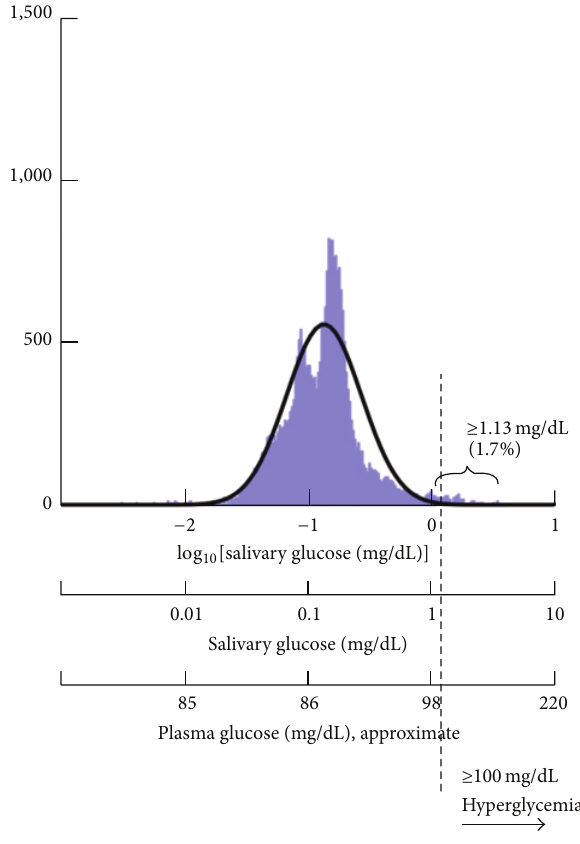
Figure 1: Semilogarithmic distribution of salivary glucose concen- tration values. Approximate values of the concentration of plasma glucose were computed from the equation [plasma = 13.5 × saliva + 84.8] [10]. The salivary glucose concentration of 1.13mg/dL was computed from the same equation and is approximately equivalent to a hyperglycemic plasma value of 100